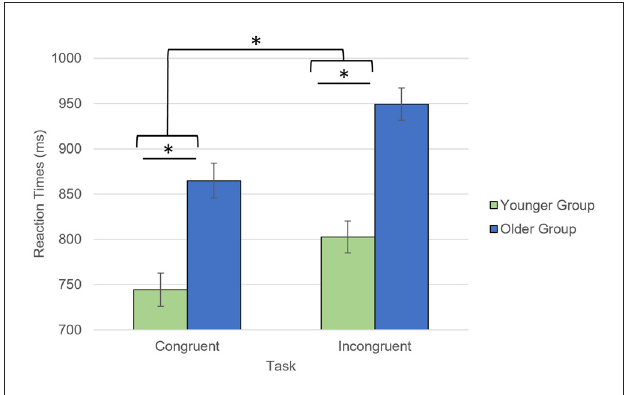
FIGURE2 Task by group interaction for the reaction times collected during the AS task. * p < 0.05. Reaction times for accurate responses were